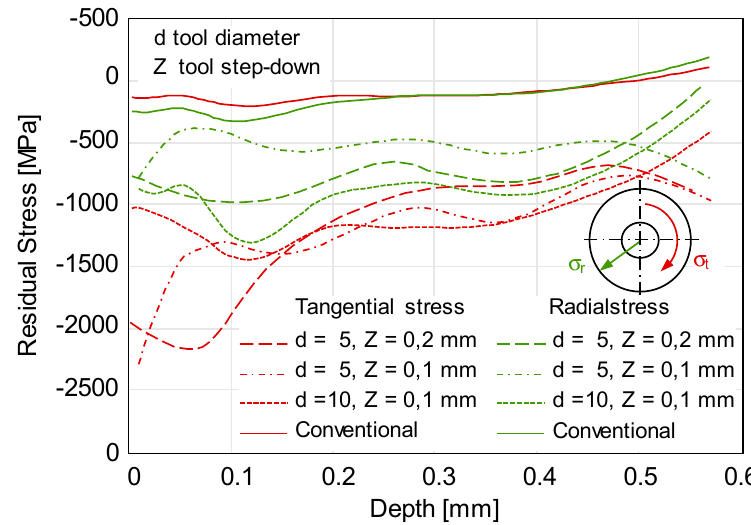
Figure 10. Residual stresses measured by the hole drilling method in conventional and in incrementally formed disc springs from steel A under varying process parameters.